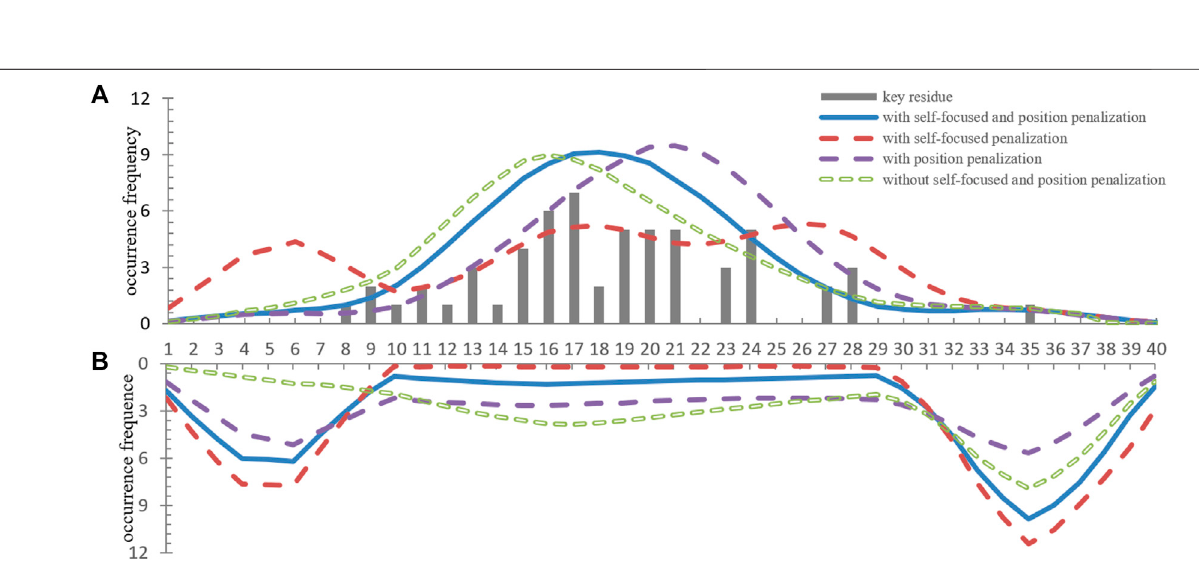
FIGURE 3 | Part localization results of GLTM with different penalization combination.